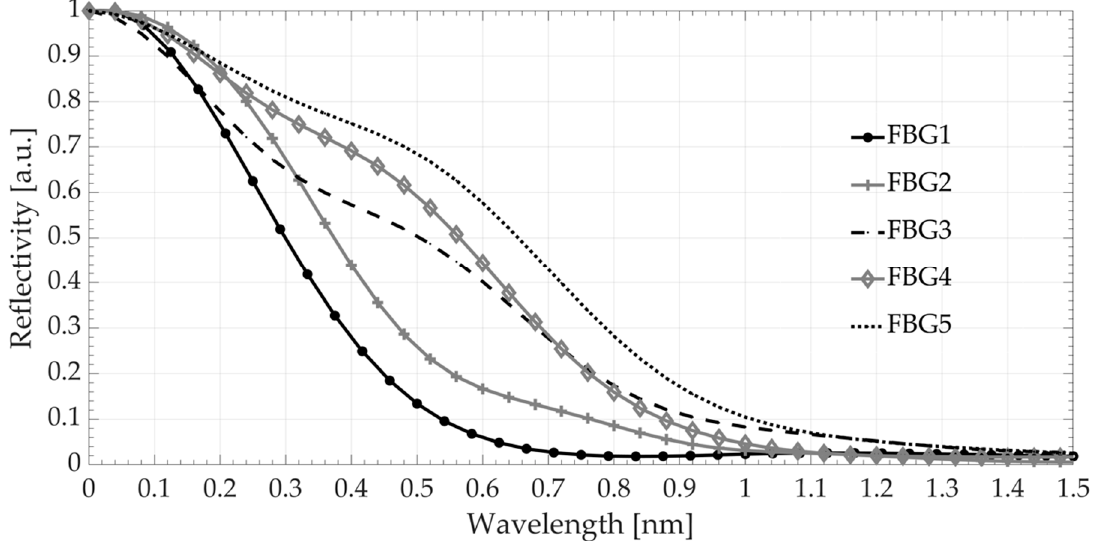
Figure 6. Calculated transfer characteristics based on the spectra of real structures.